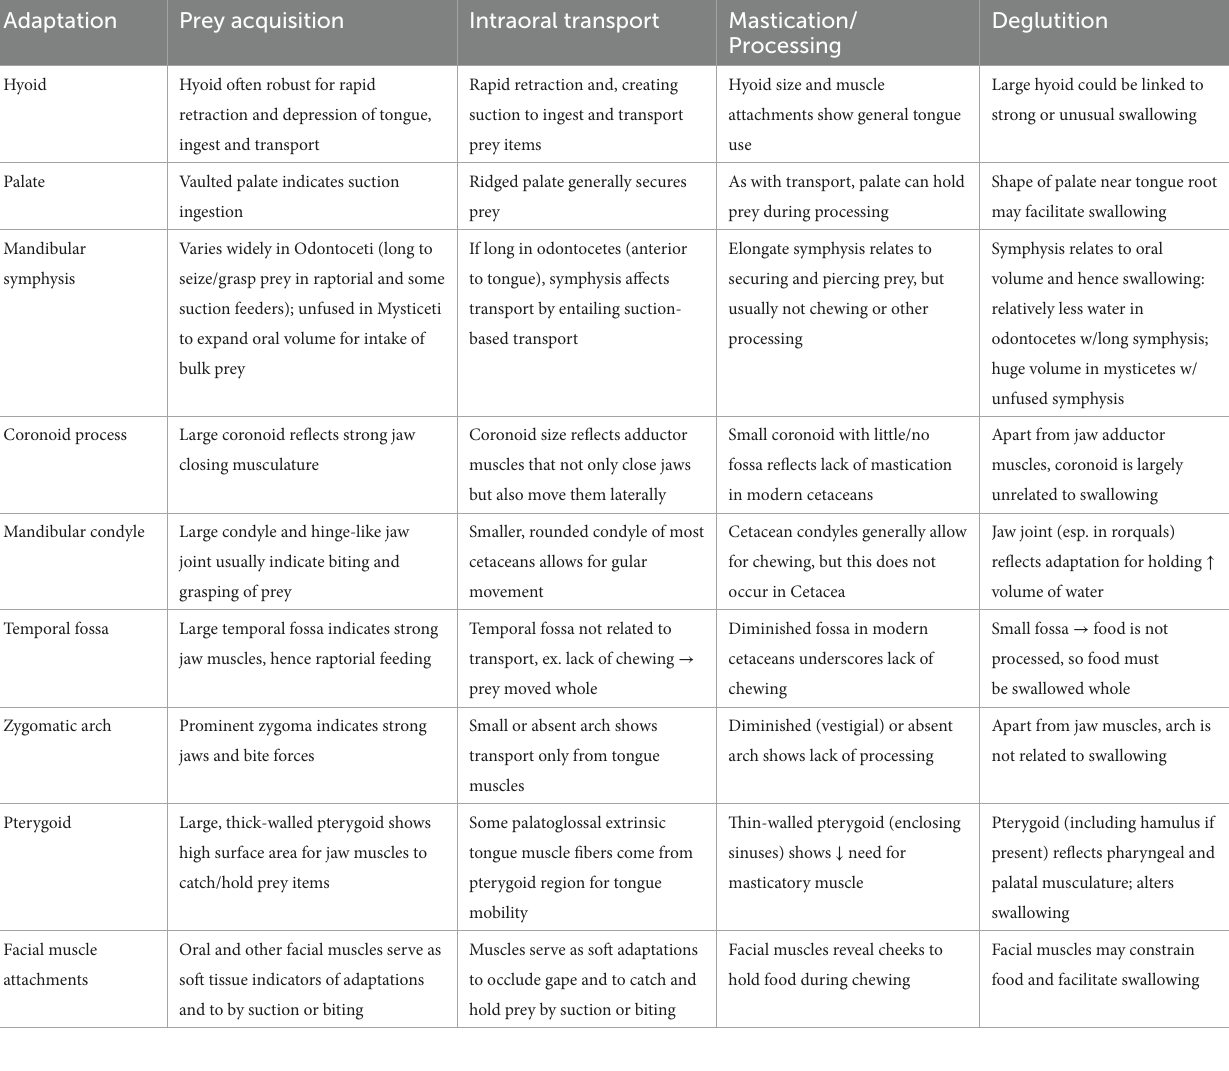
TABLE 1 Brief summary of major osteological correlates in cetaceans linked to aquatic feeding.